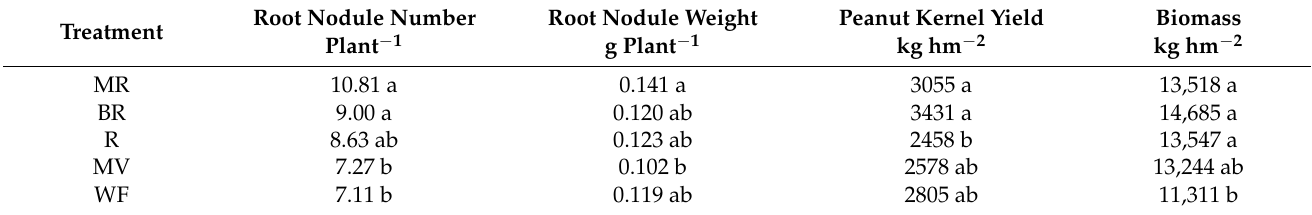
Table 4. Effects of green manure return on the growth of peanut.